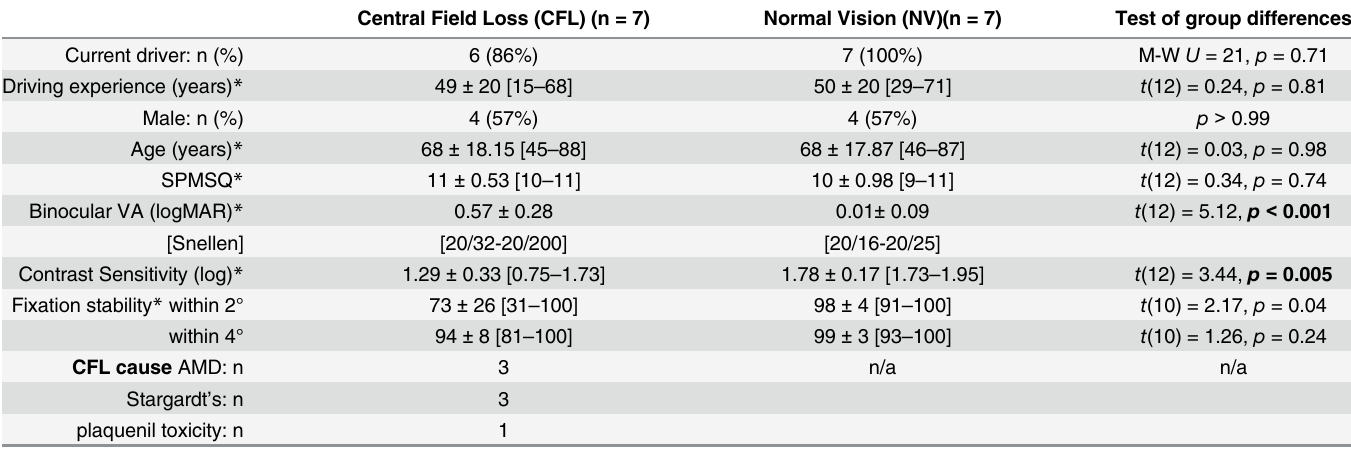
Table 1. Participant